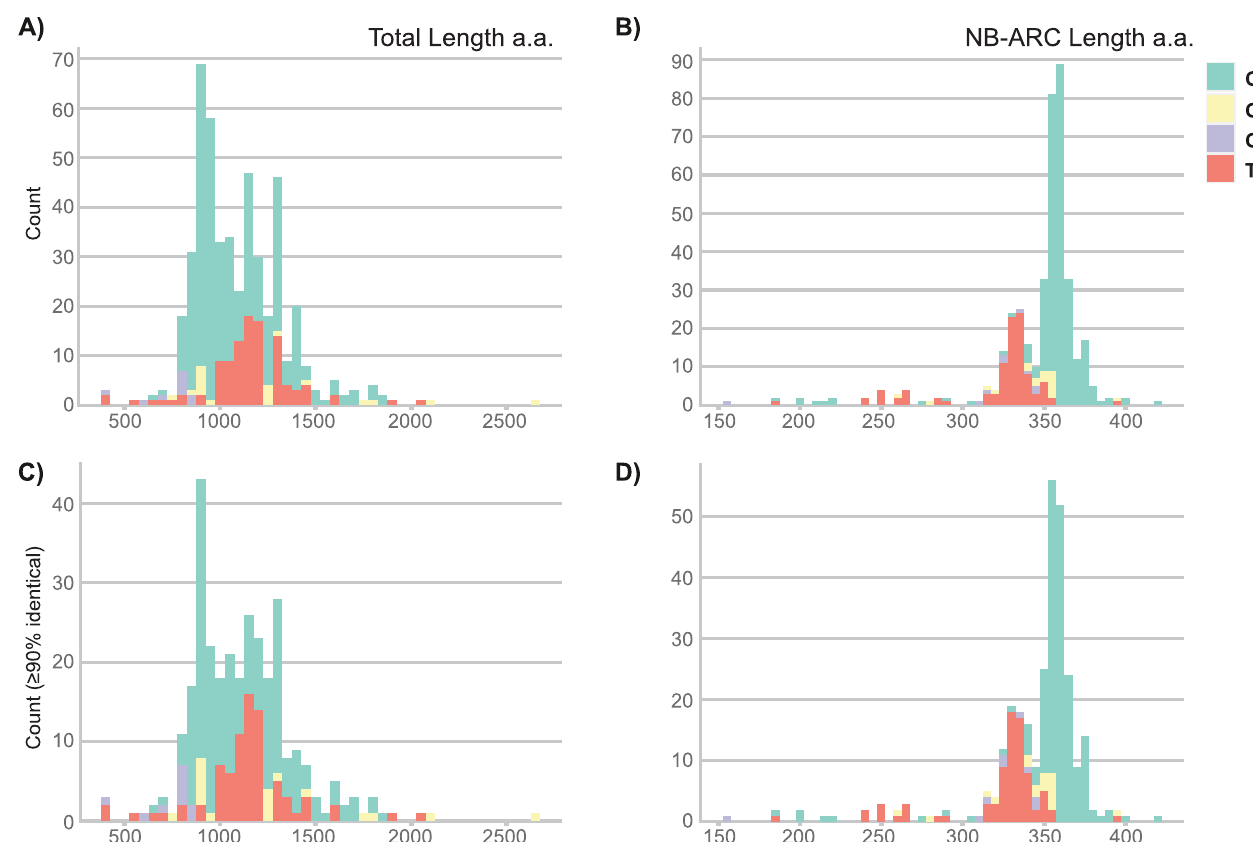
Fig 2. Length distribution RefPlantNLR amino acid sequence and extracted NB-ARC domains. Length distribution of the RefPlantNLR sequences. ( A) Histogram of RefPlantNLR amino acid sequence length (binwidth 50aa, N = 481). ( B) Histogram of the unique RefPlantNLR extracted NB-ARC domain (SUPERFAMILY signature SSF52540) amino acid sequence length (binwidth 5aa, N = 406). ( C) Histogram of amino acid sequence length of the reduced redundancy RefPlantNLR set at a 90% amino acid similarity threshold (binwidth 50aa, N = 303). ( D) Histogram of the extracted NB-ARC domain from the reduced redundancy RefPlantNLR set (binwidth 5aa, N = 296). Color coding according to NLR subfamily. Underlying data and R code to reproduce the figures in S5 Appendix . CC, coiled-coil; NB-ARC, nucleotide- binding adaptor shared by APAF-1, certain R gene products, and CED-4; NLR, nucleotide-binding leucine-rich repeat; TIR, Toll/interleukin-1 receptor.